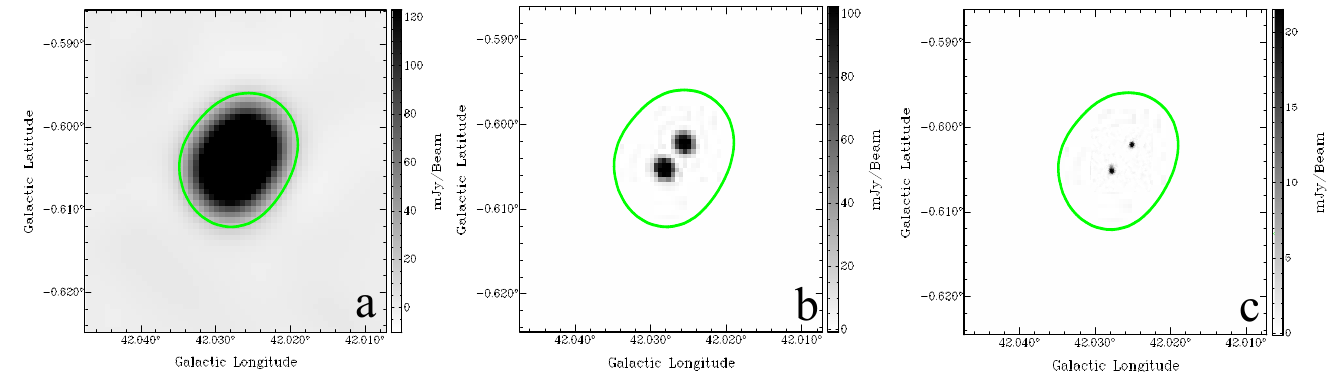
Figure 2. The non-thermal object G42.028-0.605. ( a ) THOR 1440 MHz; ( b ) MAGPIS 1.4 GHz; ( c ) CORNISH 5 GHz. The green contour line is at 0.02 Jy/beam of the THOR 1440 MHz